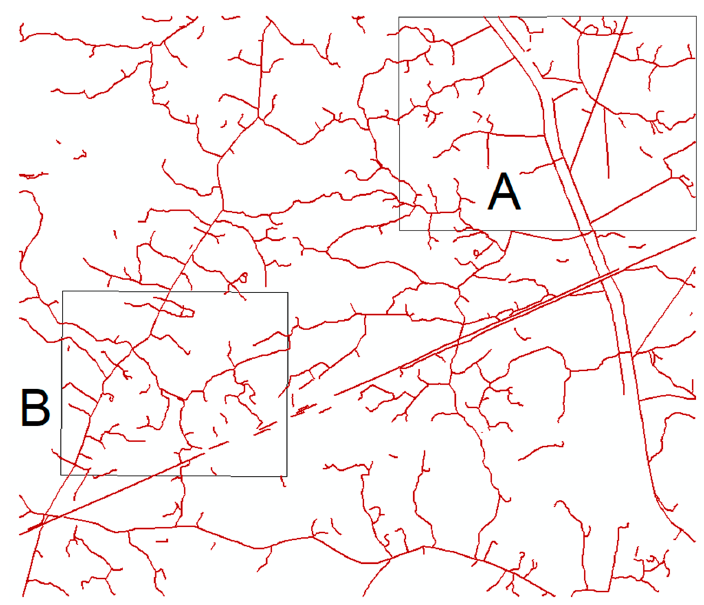
Figure 12. Road extraction result in the study area.